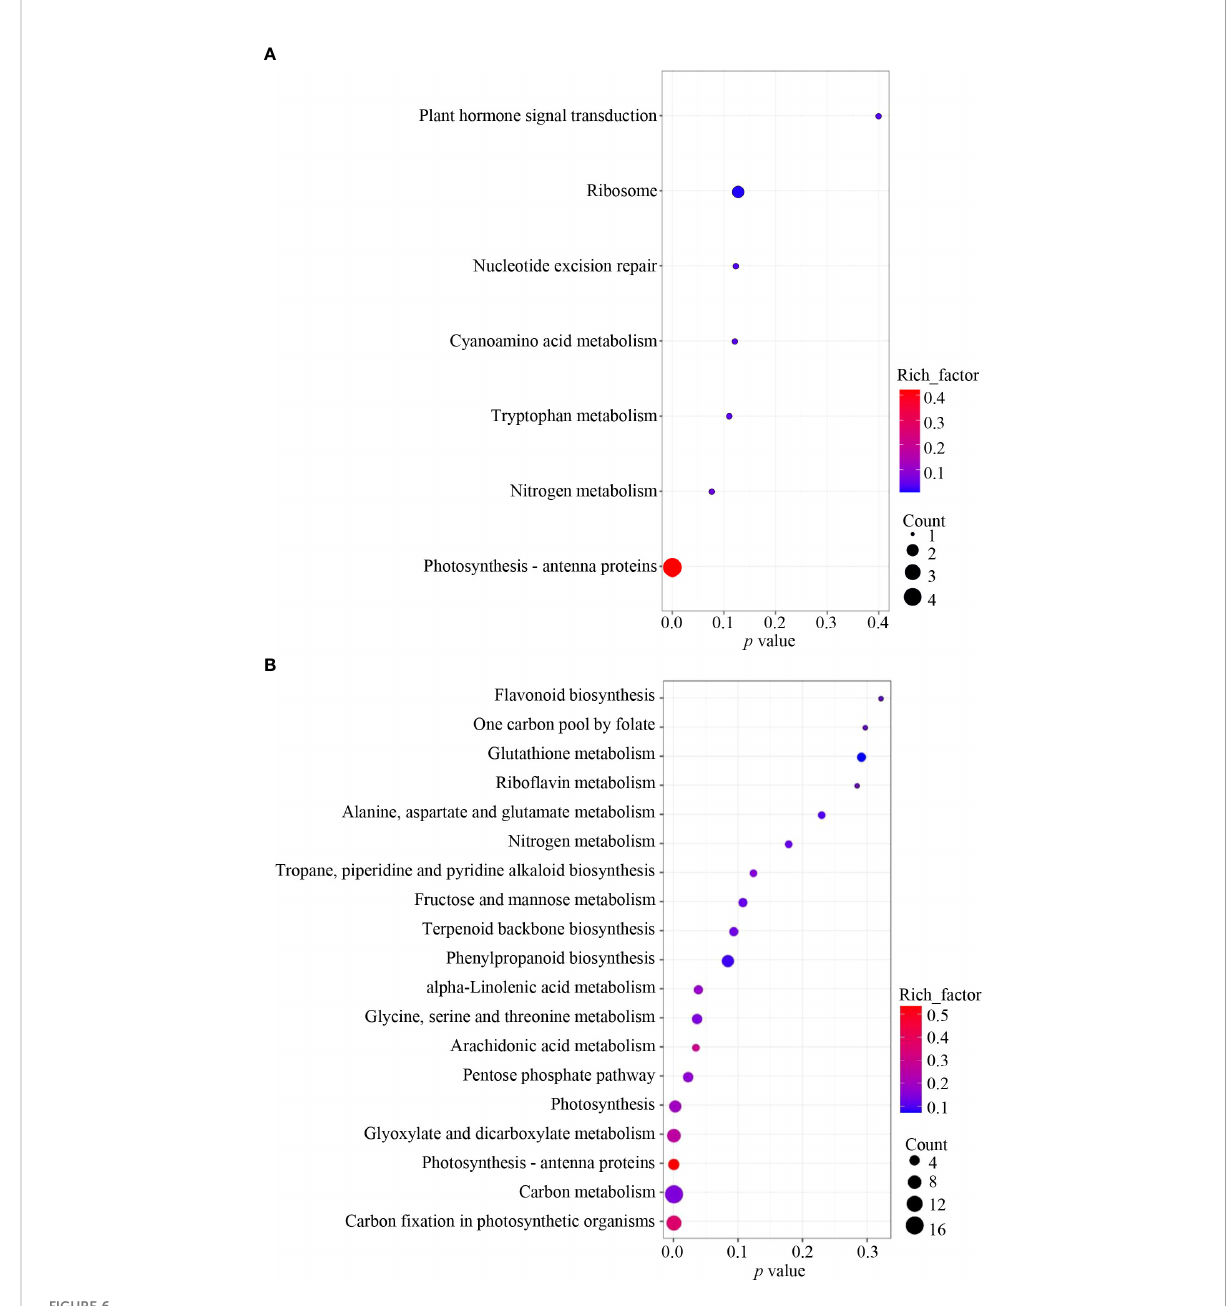
FIGURE 6 NbCIPK25 causes DEGs involved in different KEGG pathways between normal and salt treatment. (A, B) KEGG pathway enrichment analysis of total DEGs induced by NbCIPK25 overexpression under 0 mM NaCl (A) and 100 mM NaCl treatment (B) . Dot size indicates the DEG numbers. P values locate at the bottom of each fi